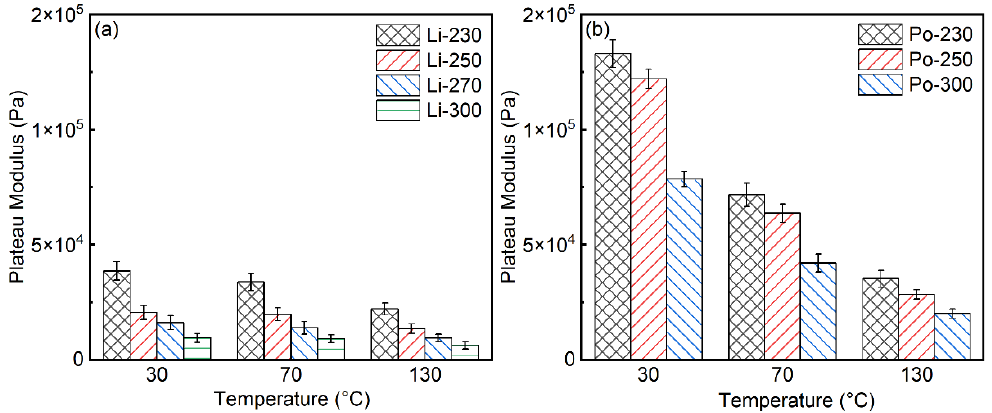
Figure 2. Plateau modulus G N of greases at different temperatures: ( a ) lithium greases, ( b ) polyurea greases.